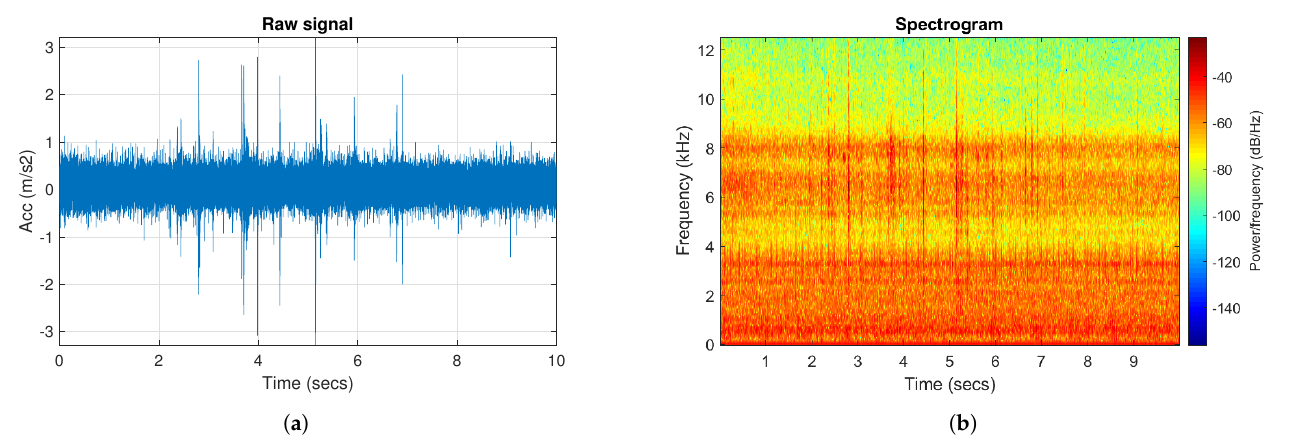
Figure 14. ( a ) Real signal r 1 , ( b ) spectrogram of real signal r 1